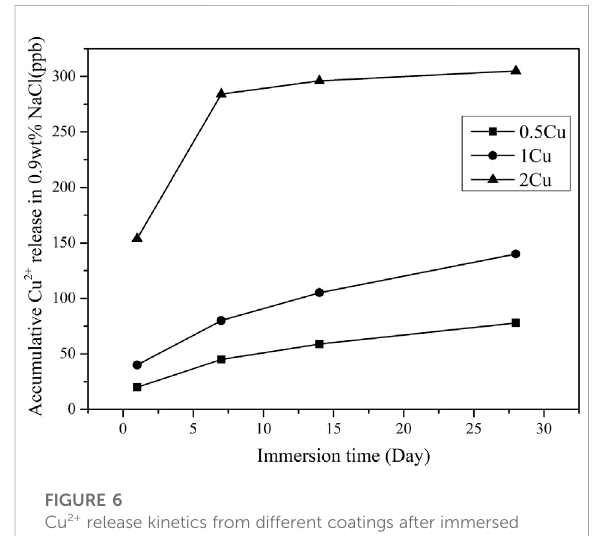
FIGURE 6 Cu 2+ release kinetics from different coatings after immersed in 0.9 wt% NaCl for 1 – 28